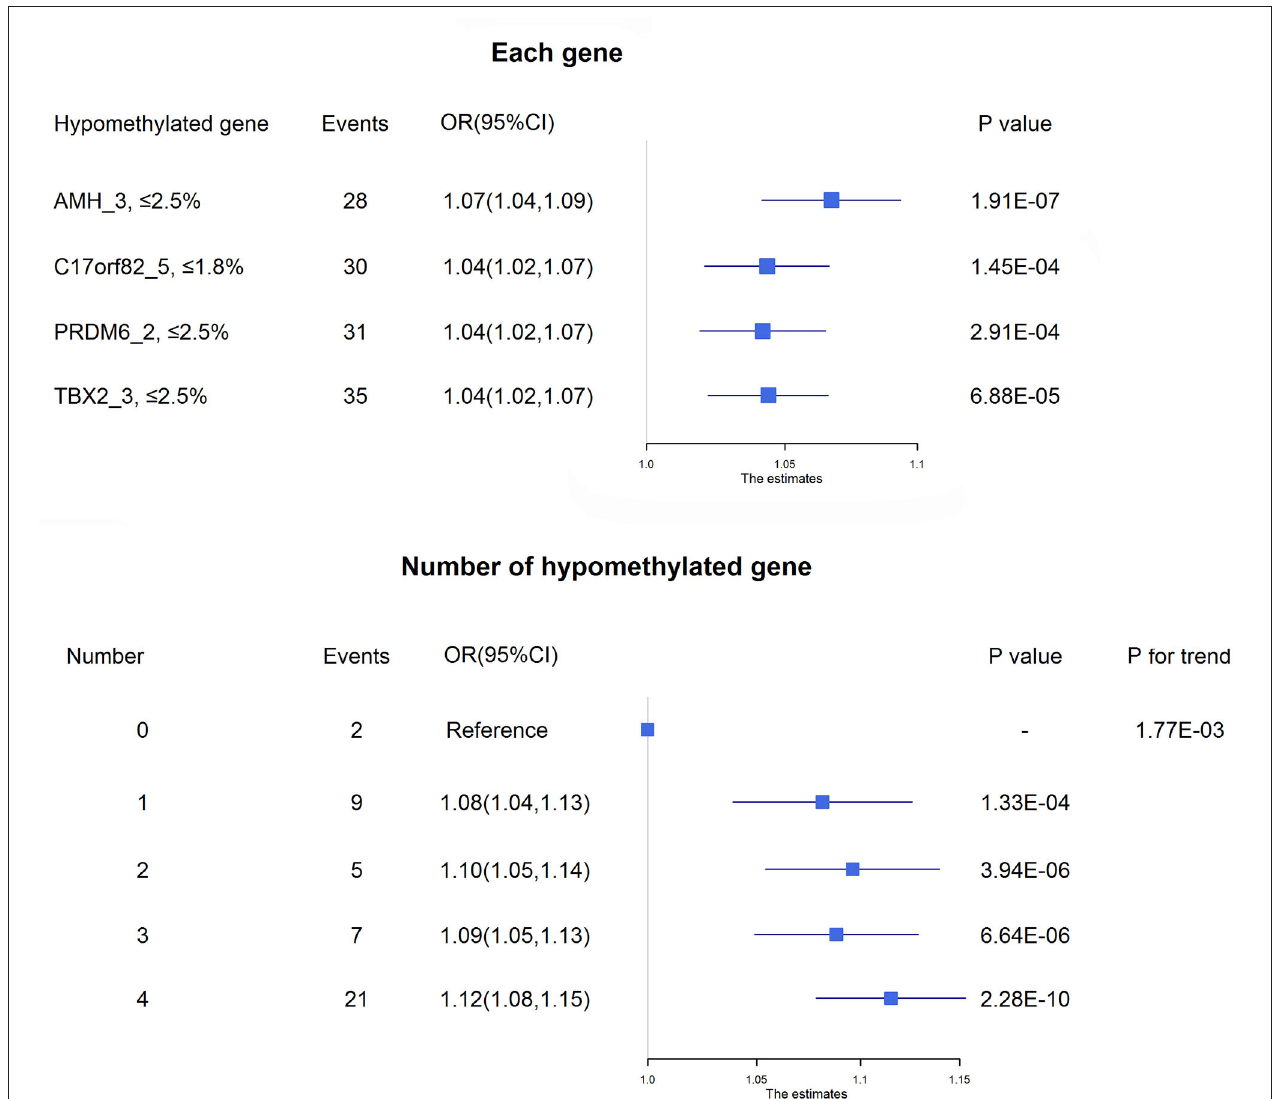
FIGURE 3 | Association between DNA methylation and 3-month mortality. The upper panel shows the adjusted ORs and corresponding 95% CIs for the associations between hypomethylation of each target and 3-month mortality. The lower panel shows the adjusted ORs and corresponding 95% CIs for 3-month mortality according to the number of hypomethylated targets among acute ischemic stroke